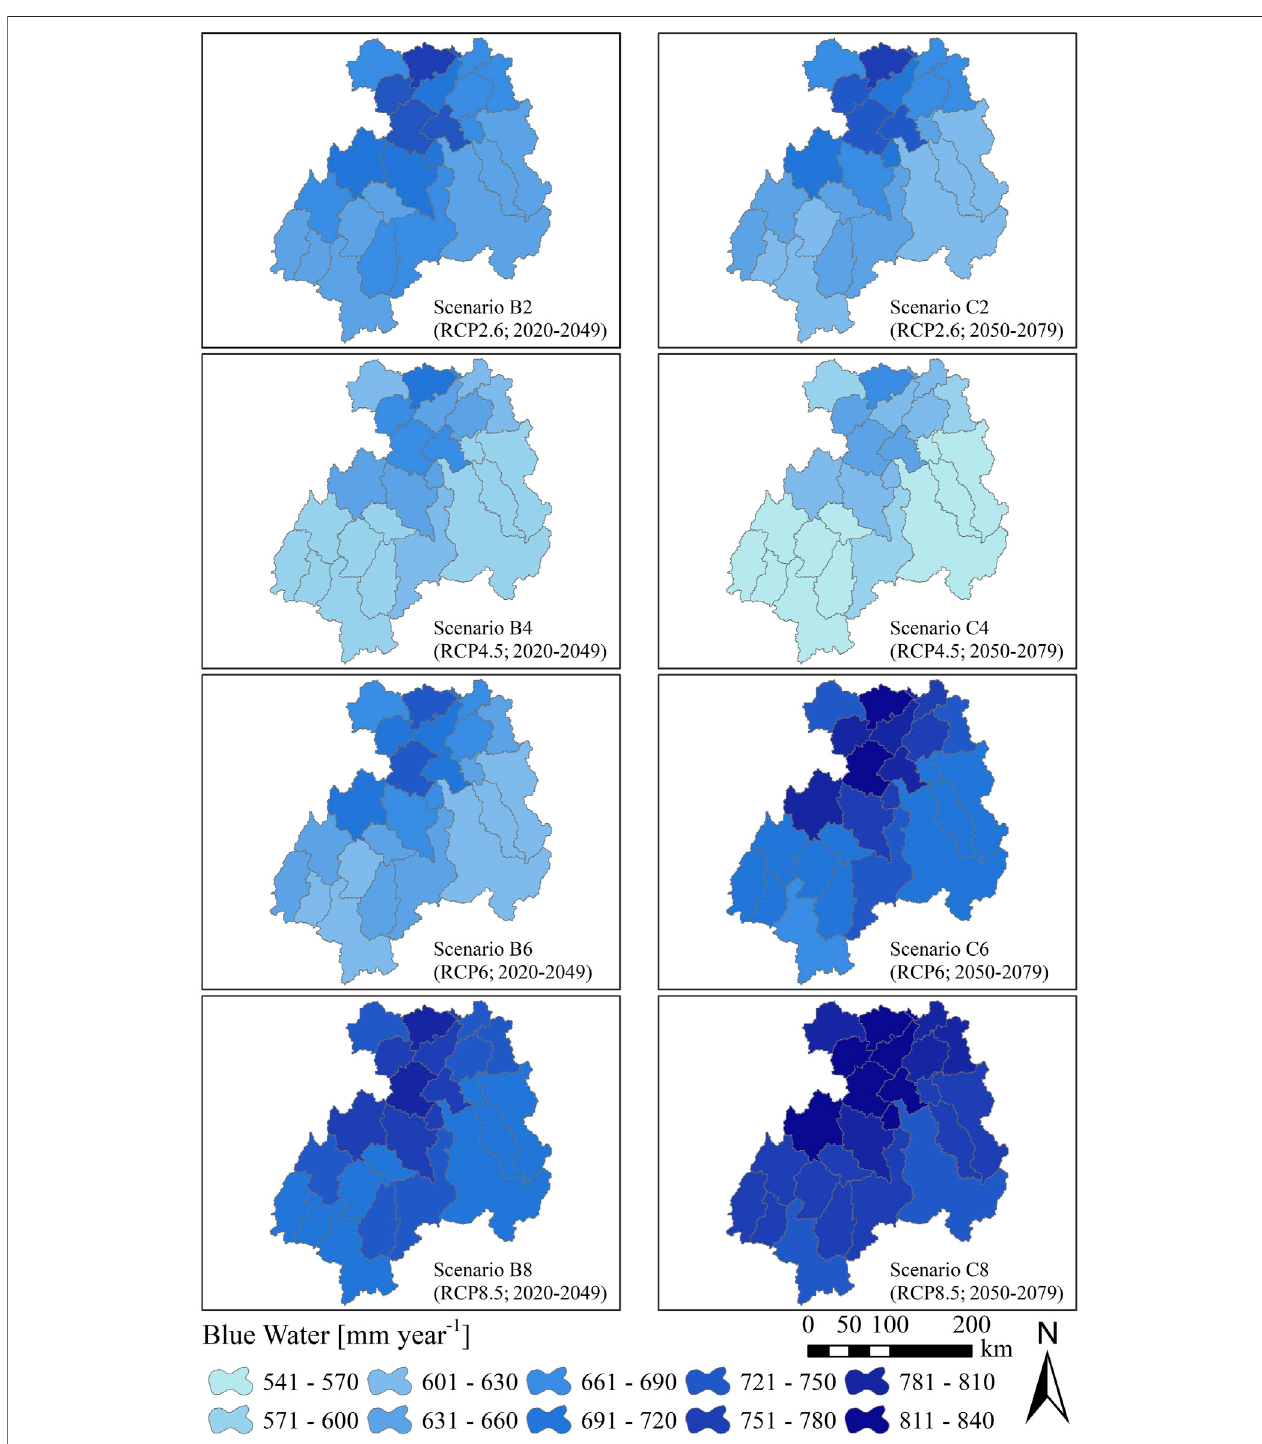
FIGURE 10 | Spatial distributions of the annual average blue water resources (mm yr − 1 ) under different RCPs in future HadCM3 climate scenarios (2020 – 2079) in the Xiangjiang River Basin.